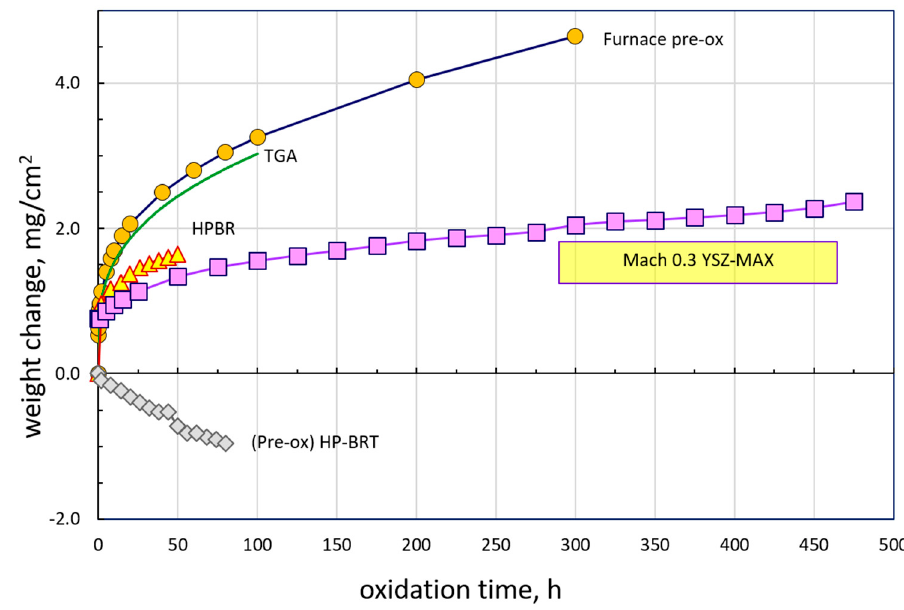
Figure 1. Comparison of 1300 °C Ti 2 AlC furnace and burner oxidation data. Mach 0.3 burner at 1 atm. and 100 m/s; HPBR at 6 atm. and 25 m/s, TGA dry air, and ambient air furnace tests.